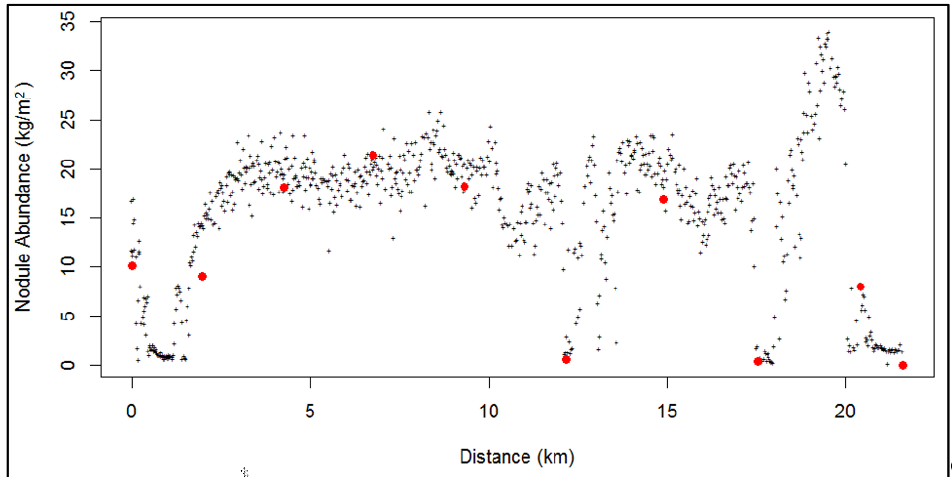
Figure 22. Nodule abundance photo-profile line CCZ15-F04 that crosses sub-area B1 for measured mineral resources. Source: [12]. Red dots — nodule coverage for seafloor photos that were used in the manual estimate of abundance using the long-axis estimation method and in the measured mineral resource estimate. Black dots — nodule abundance for all other seafloor photos derived by automated processing.